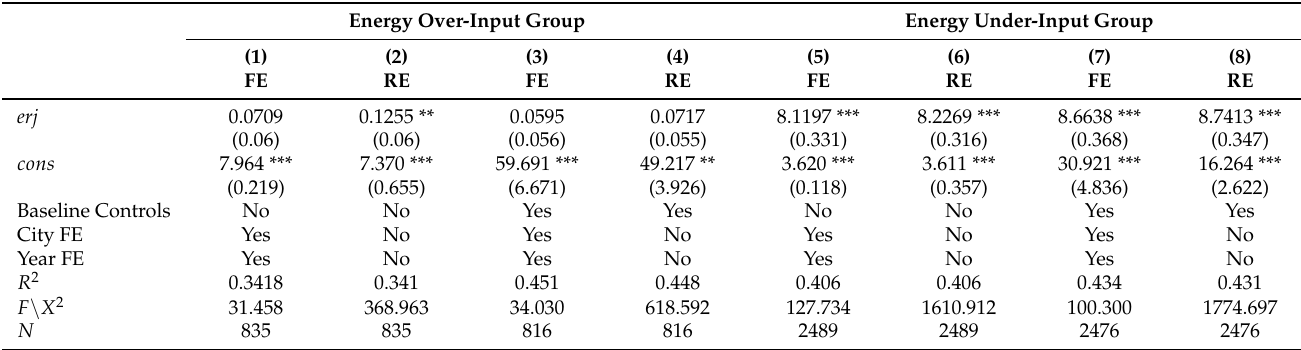
Table 5. Differences in the impact of energy inputs on CO 2 emissions between the over-input and under-input